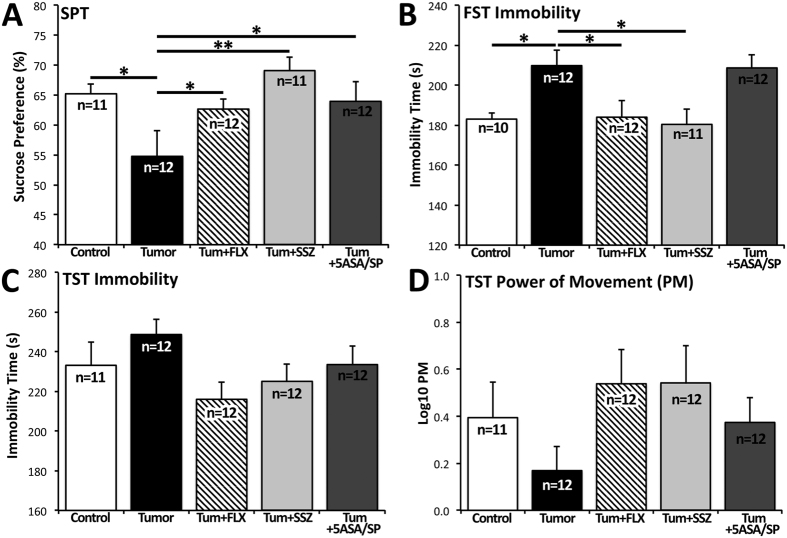
Behavioural results for the 5 experimental groups: control, tumour, tum+FLX, tum+SSZ, tum+5-ASA/SP.(A) In the sucrose preference test (SPT) preference is calculated as (sucrose water consumption/total fluid intake) × 100, where 50% represents equal consumption of sucrose water and regular water. Tumour mice showed a lower sucrose preference compared to control (P = 0.026). Treatments with FLX, SSZ, and 5-ASA/SP were associated with higher sucrose preference compared to untreated tumour mice (P = 0.040, P = 0.002, P = 0.035, respectively). (B) In the forced swim test (FST), tumour mice had higher immobility time compared to control mice (P = 0.033). FLX and SSZ were associated with lower immobility times compared to untreated tumour mice (P = 0.033, P = 0.019, respectively). (C) In the tail suspension test (TST), no significant changes were observed. Trends indicated a lower immobility time and higher log10 PM associated with FLX and SSZ treatments compared to untreated mice. Data are presented as mean ± SEM. Results were analyzed using one-way ANOVA. The Holm-Šidák correction was used to correct for multiple comparisons. *P < 0.05, **P < 0.01.